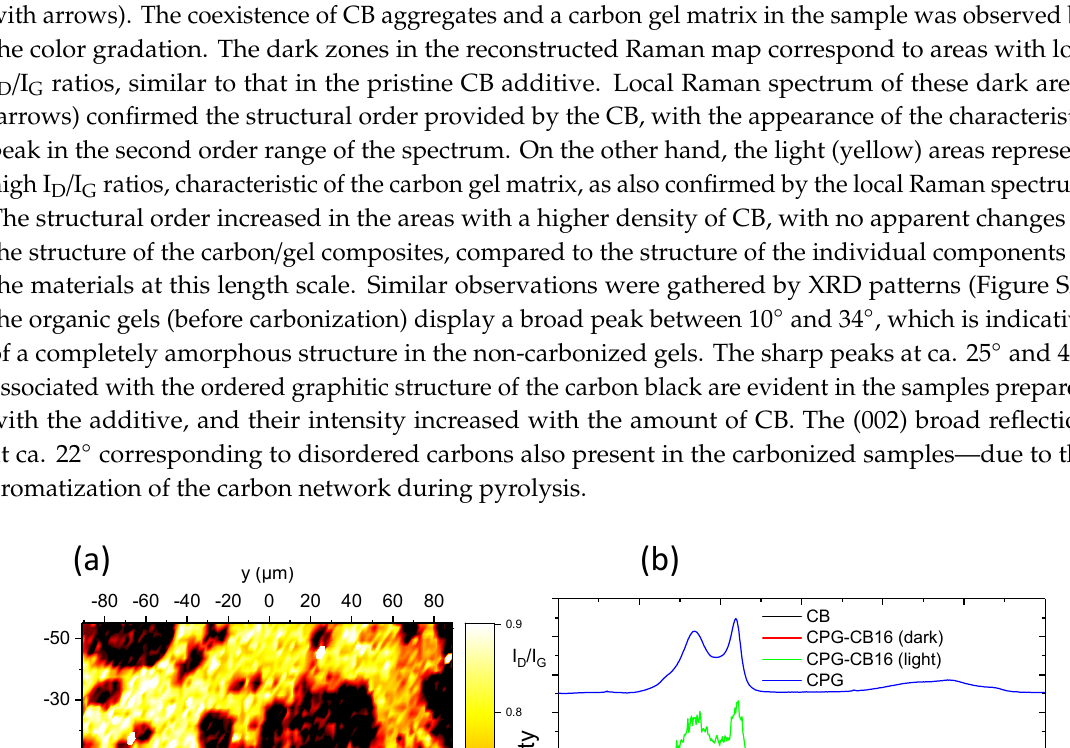
Table 1. Carbonization yield and main textural parameters obtained from the N 2 adsorption isotherms for the materials synthesized with different amounts of CB additive.